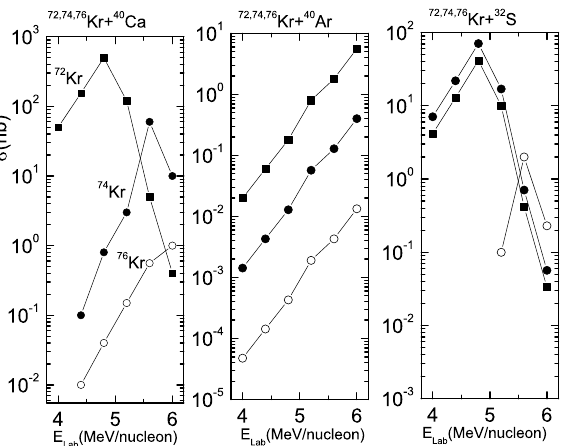
Fig. 1. Excitation functions for the production of 100 Sn in the re- actions 72 , 74 , 76 Kr + 40 Ca, 72 , 74 , 76 Kr + 40 Ar and 72 , 74 , 76 Kr + 32 S at 4 − 6 MeV / nucleon. Open circles are for 76 Kr, solid circles are for 74 Kr, and solid squares are for 72